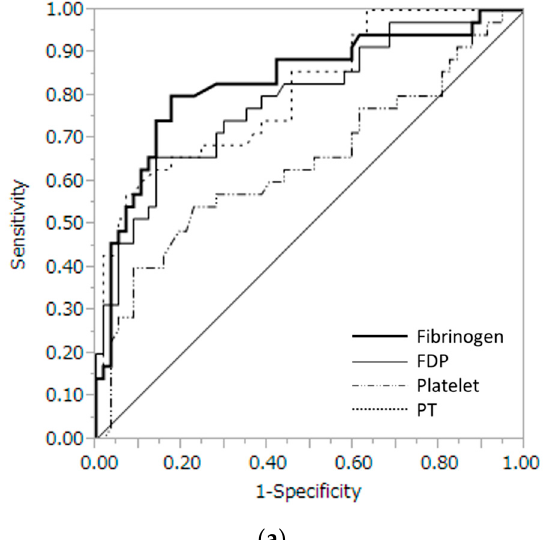
Figure 1. ( a ) Receiver operating characteristic curve with several coagulation profiles. ( b ) Fibrinogen levels with a cutoff of 288 ng/dL had the highest accuracy with an AUC of 0.85 (95% CI, 0.743–0.918). AUC, area under the curve; CI, confidence interval; FDP, fibrin/fibrinogen degradation products; PT, prothrombin time.